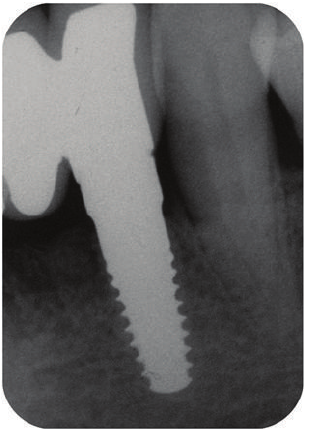
Figure 11: X-ray picture of the zirconia implant placed in area 3.2, six months after